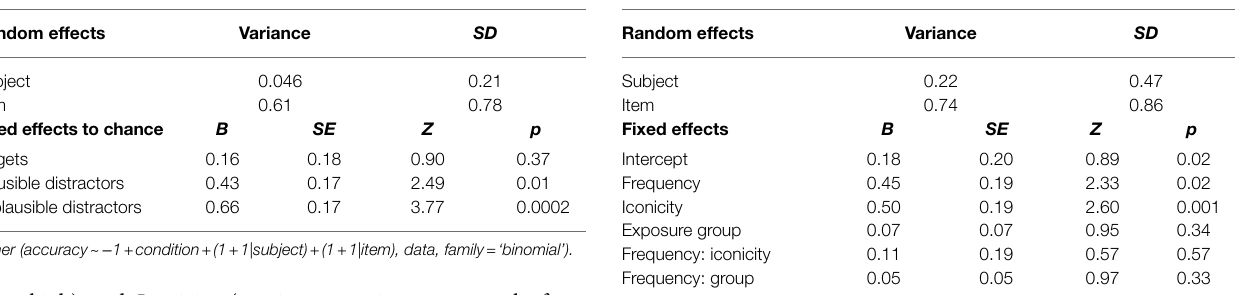
TABLE 5 | Model output for the comparison of accuracy to chance by condition. TABLE 6 | Model output accuracy by frequency and